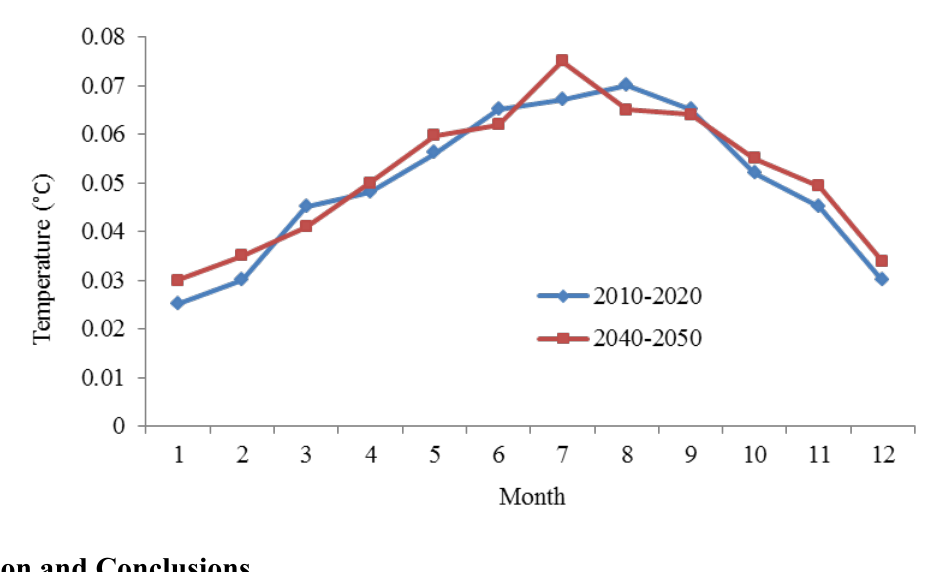
Figure 9. Effects of future grassland degradation on average monthly temperature during two decades in